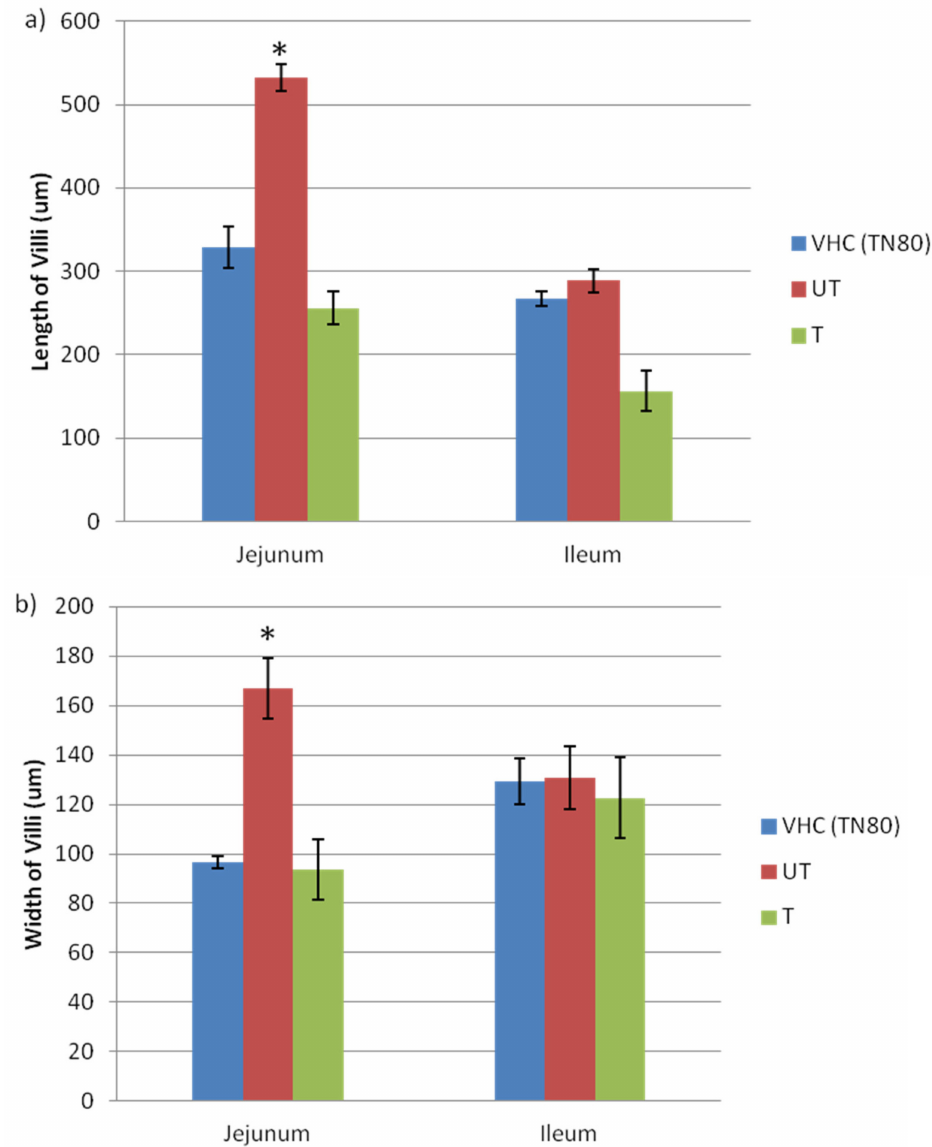
Figure 4. Effects of BPA on general parameters of villi in the jejunum and ileum of pregnant rats ( a ). Length of villi ( b ). Width of villi. ( n = 3–5 rats per group). * Significant as compared to VHC group at p <